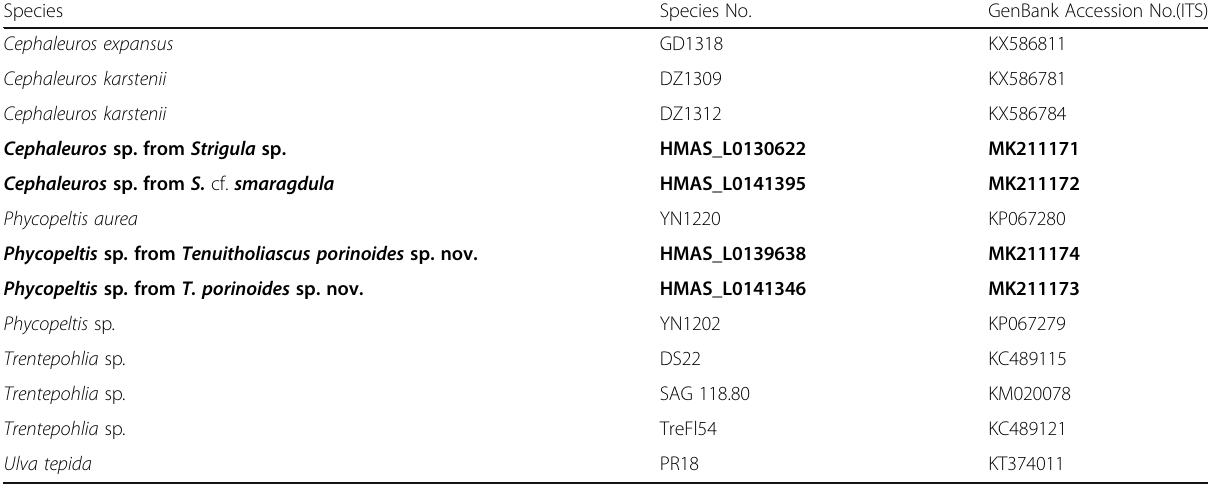
Table 2 Sequences of photobiont Trentepohliaceae . The new sequences generated were in bold Species Species